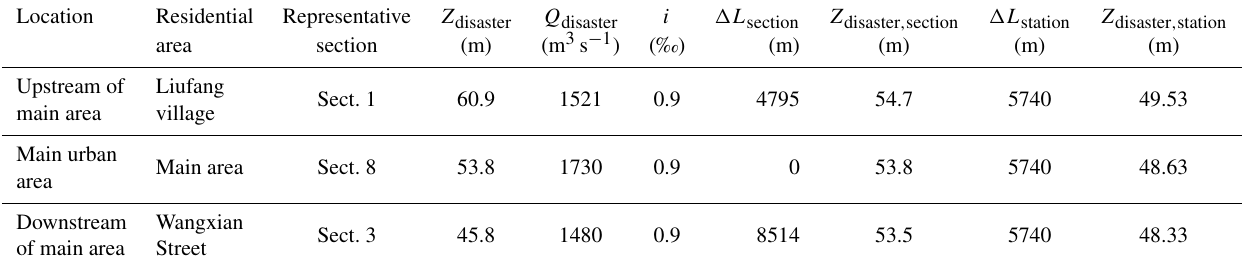
Table 2. Analysis results of disaster water level in downtown area of Shitai and villages related to upstream and downstream. Location